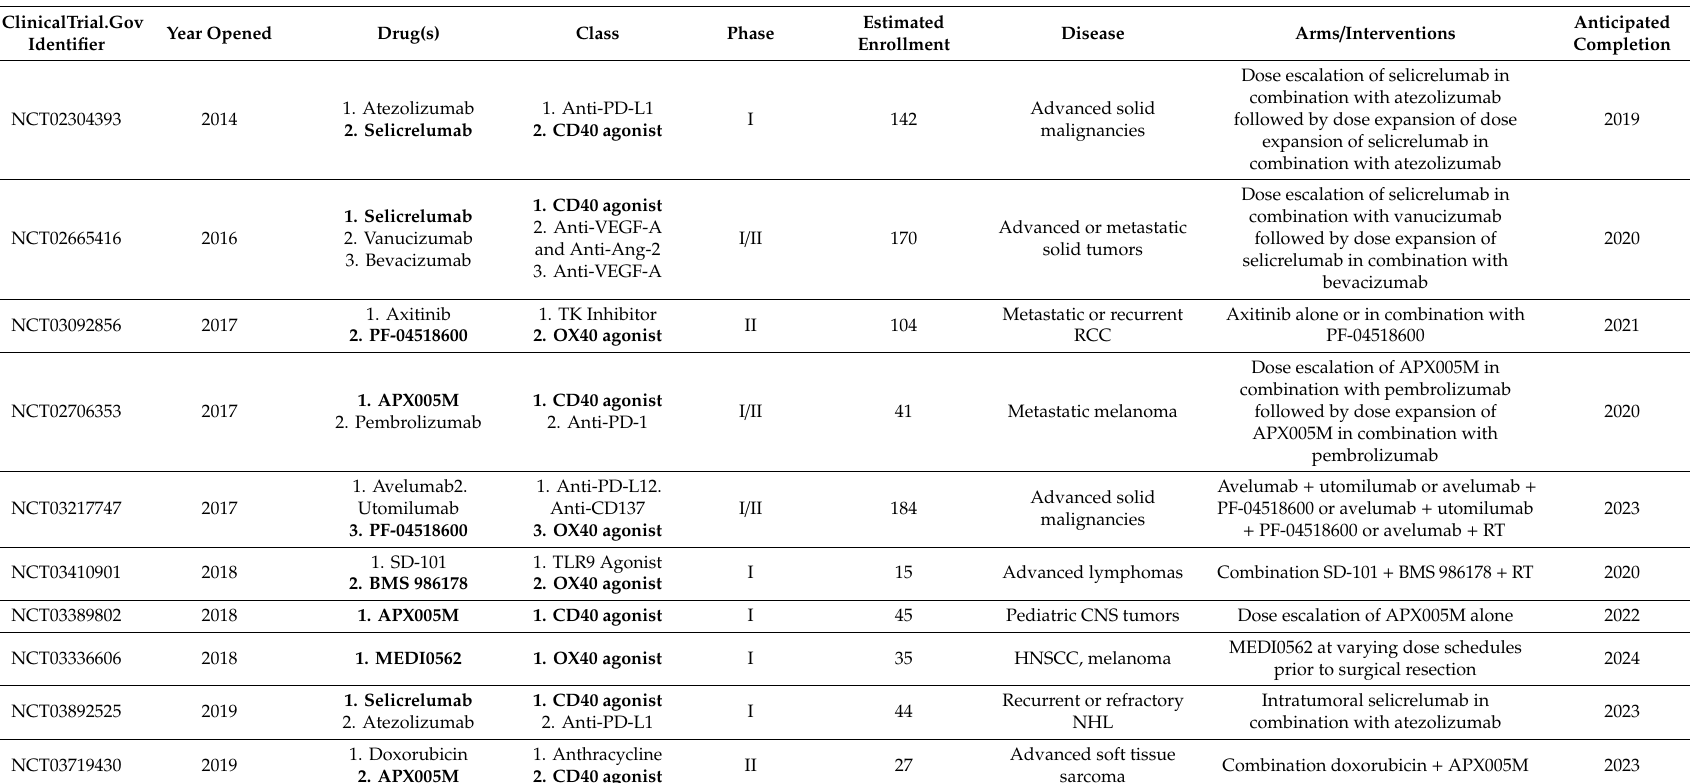
Table A7. Ongoing trials involving CD40 agonists or OX40